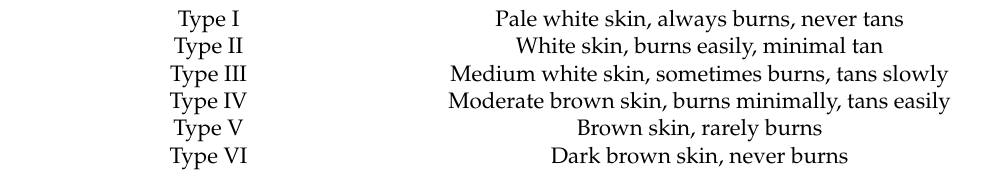
Table 2. The Fitzpatrick Skin Phototype Classification